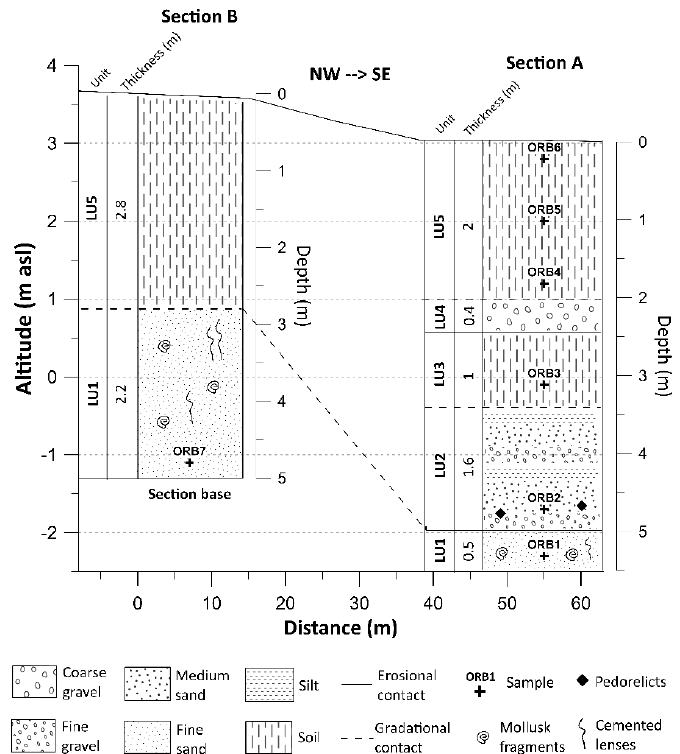
Figure 4. Stratigraphy of the sections with the location of the collected samples. Section A (on the right) and Section B (on the left) are about 50 m apart. LU1-LU5 are lithostratigraphic units (see text). The graph shows both elevation and depth from the ground level. The width of the sections is not in scale. See Figure 3 for the location of the sections.